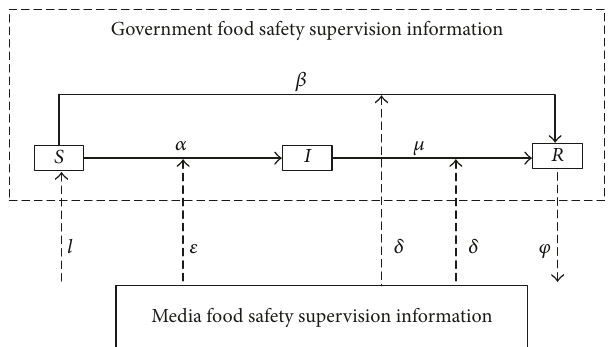
Figure 2: Diffusion model of food safety scare behavior under the effect of information